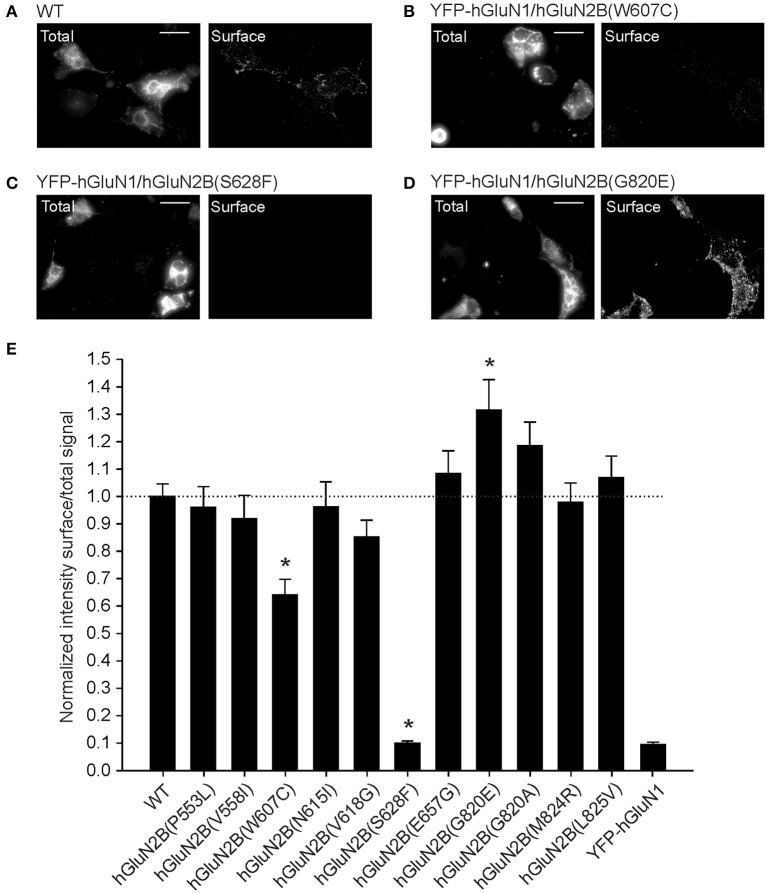
Mutations in the TMD of hGluN2B subunit affect the NMDAR surface expression. (A–D) Representative images of the total (left panel) and surface (right panel) pools of YFP-hGluN1 expressed in COS-7 cells. COS-7 cells were transfected with WT (A), YFP-hGluN1/hGluN2B(W607C) (B), YFP-hGluN1/hGluN2B(S628F) (C), and YFP-hGluN1/hGluN2B(G820E) (D) receptors. A scale bar in (A–D) represents 20 μm. (E) An immunofluorescence microscopy was used to determine relative surface-to-total NMDAR levels in COS-7 cells transfected with only YFP-hGluN1 subunit for control (YFP-hGluN1) or both the YFP-hGluN1 and hGluN2B (WT) or mutated hGluN2B subunit. Data show mean ± SEM; n = 35 in three experiments. *p < 0.05 relative to WT, one-way ANOVA (Multiple comparisons vs. WT-Dunnett's method). For original images see (Supplementary Figures S5–S12).